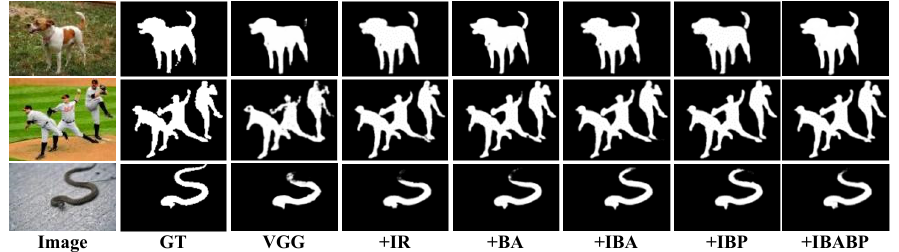
Figure 7. Visual comparison of each module. GT: ground truth; IR: IRM; BA: BAM; IBA: IRM + BAM; BP: IRM + BPM; IBABP: IRM + BAM +